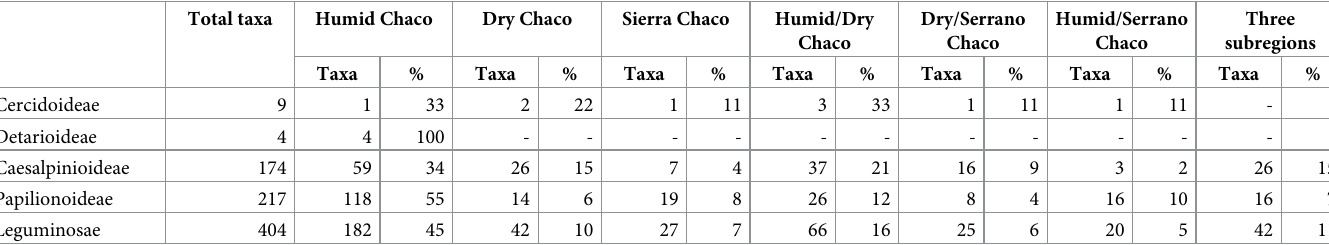
Table 8. Classification of Chaco species and infraspecific taxa according to occurrence per subregions. Total taxa